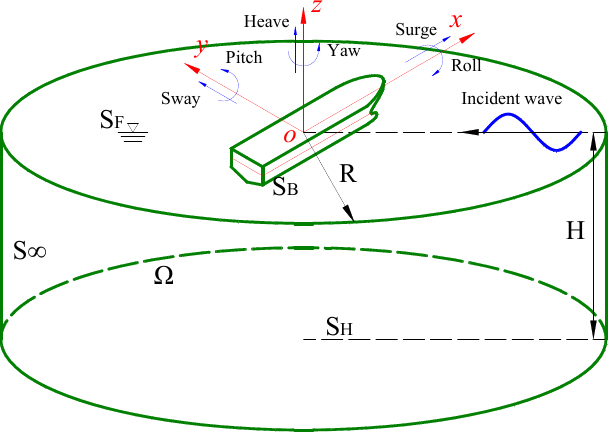
Figure 2. Description of ship–wave interaction issue.